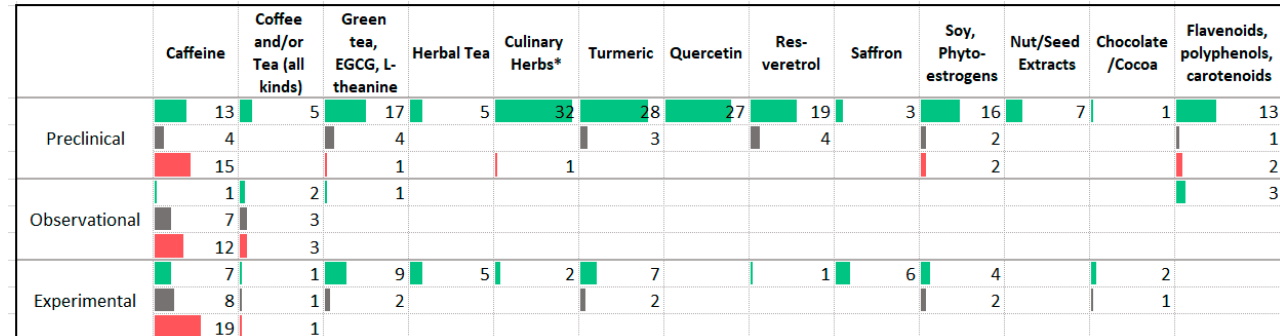
Figure 13. Studies assessing phytochemicals and anxiety * Culinary Herbs: rosemary, cinnamon, coriander, basil, nigella; Herbal tea: chamomile, hibiscus, rose tea. █ Higher intake or levels associated with decreased anxiety. █ No association between intake or levels and anxiety. █ Higher intake or levels associated with increased anxiety.